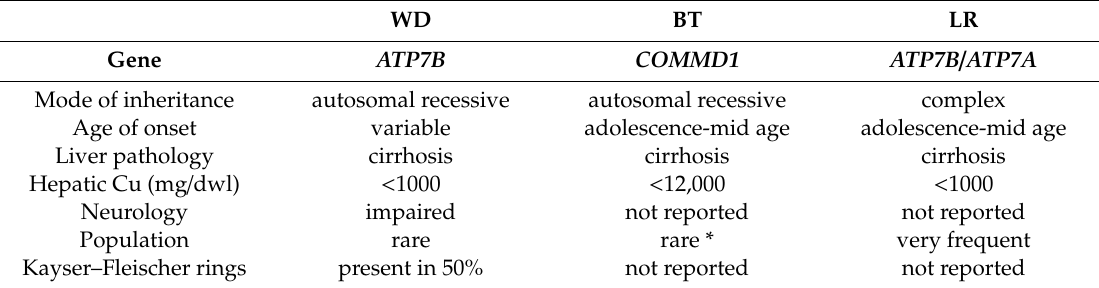
Table 1. Comparison of some parameters for Wilson Disease (WD) patients with potential large animal models such as Bedlington terriers (BT) and Labrador retrievers (LR). WD BT LR Gene ATP7B COMMD1 ATP7B /